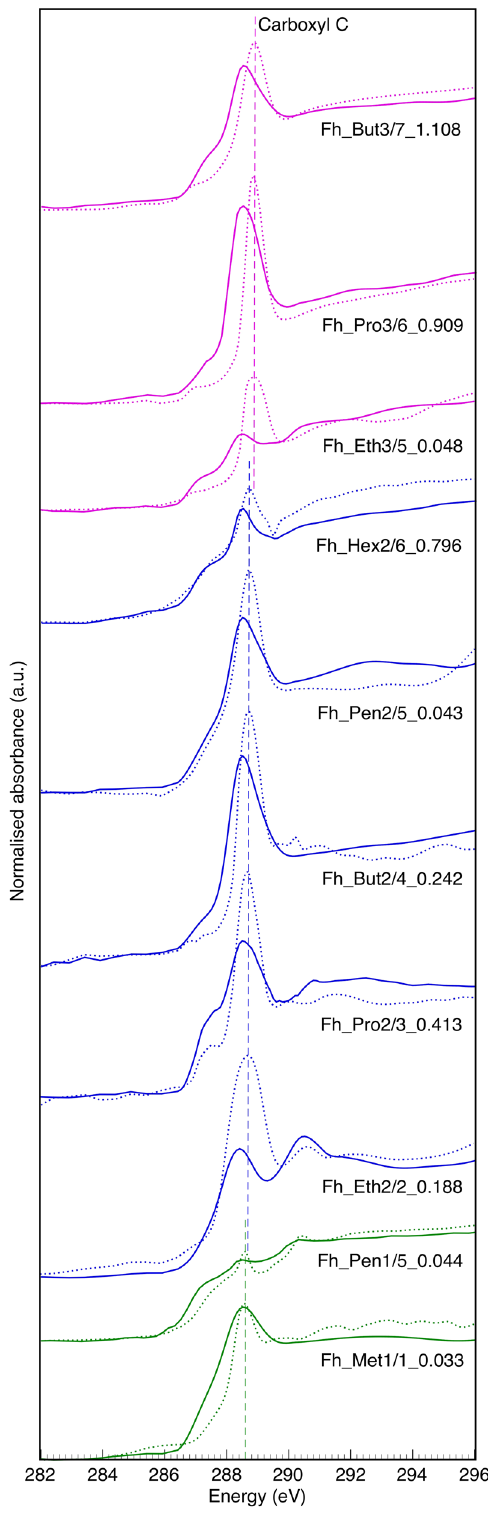
Supplementary Fig. 3 and Supplementary Fig. 4 for extended discussion).